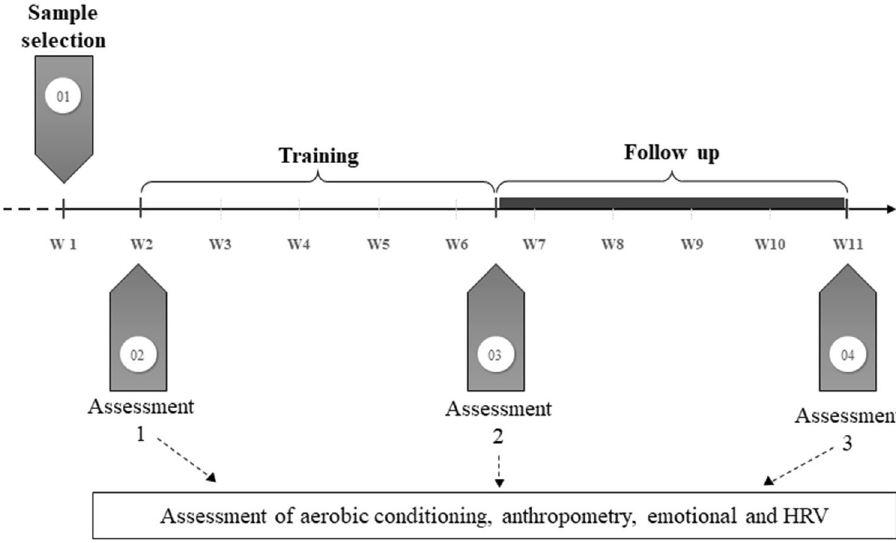
Figure 4. Experimental